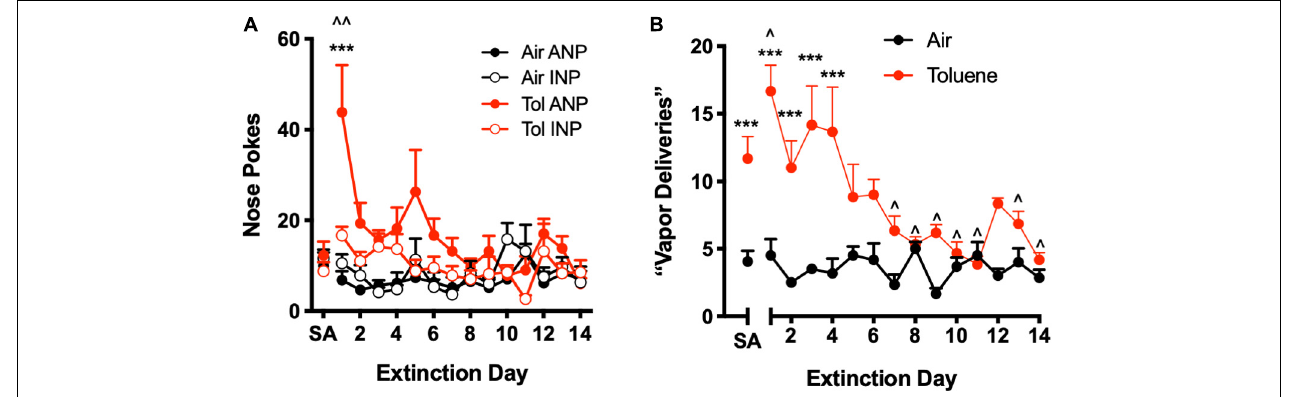
FIGURE 3 | Extinction of operant responding for toluene vapor. During extinction training, a nose poke in the active hole had no consequence (i.e., did not trigger toluene delivery or conditioned cues). (A) Number of active (ANP) and inactive nose pokes (INP) for Air SA and Tol SA rats during extinction training. SA is average ANP and INP during last week of self-administration; ˆˆ p < 0.01 Tol ANP EXT vs. Tol SA, *** p < 0.001 Tol ANP EXT vs. Tol INP EXT, Sidak’s post hoc . (B) Number of ANPs that would trigger a toluene vapor delivery under normal SA conditions. SA is average number of vapor deliveries during last week of self-administration; ˆ p < 0.05, Tol EXT vs. Tol SA, *** p < 0.001 Tol vs. Air, Sidak’s post hoc . All data are mean + SEM. Air N = 6, Tol N =